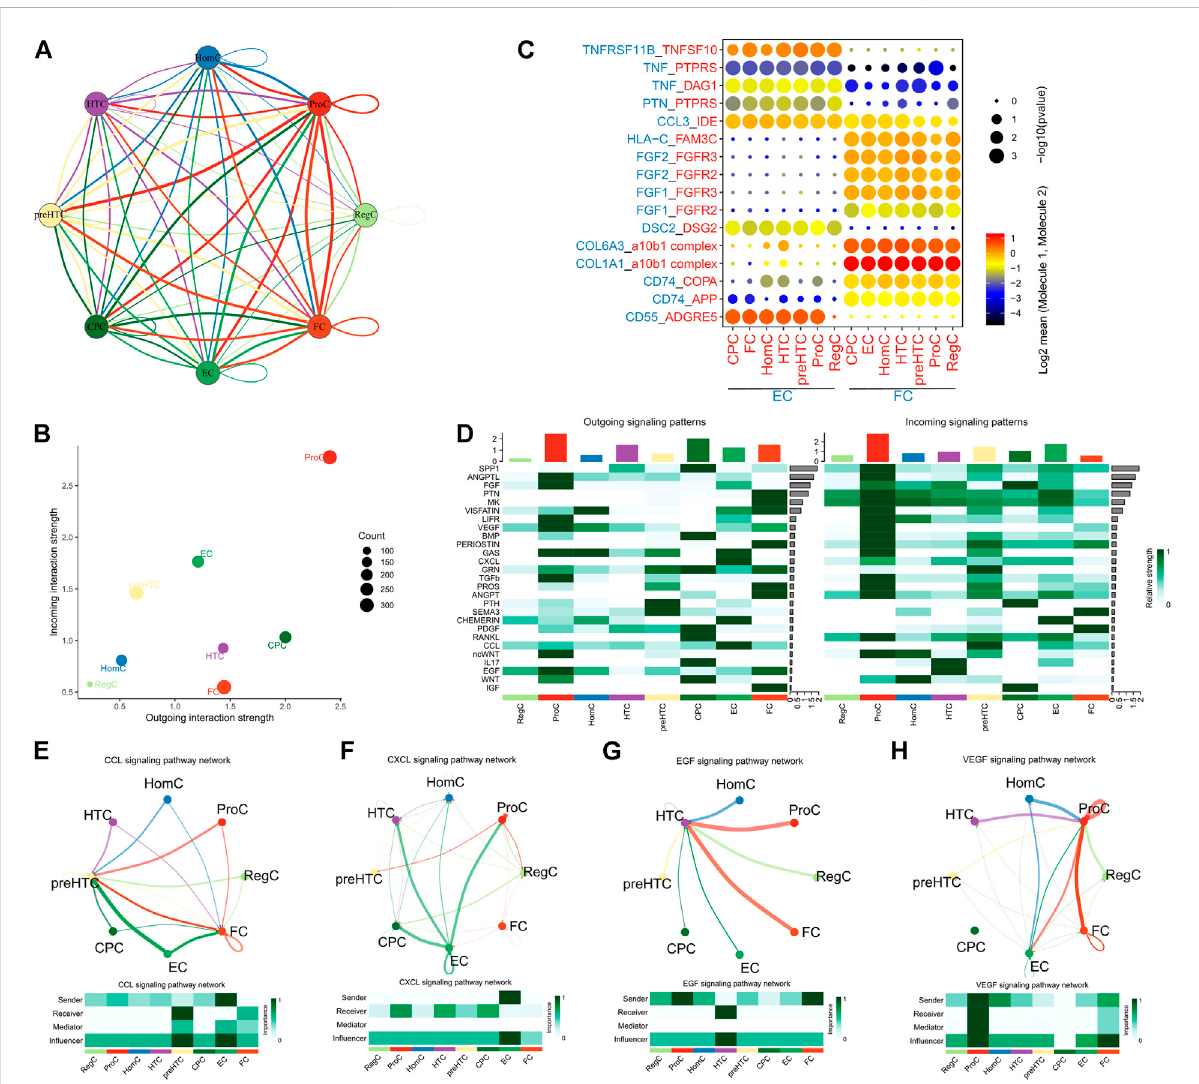
Supplementary Table S5. The above results illustrated that ECs have stronger immunogenicity than FCs and they participate in immunoregulation via regulating multiple signaling pathways. In the meantime, FCs show stronger catabolic function and have higher levels of amino acid metabolism and protein transportation involved in glycolysis and gluconeogenesis. All these fi ndings are consistent with the previous were shown in